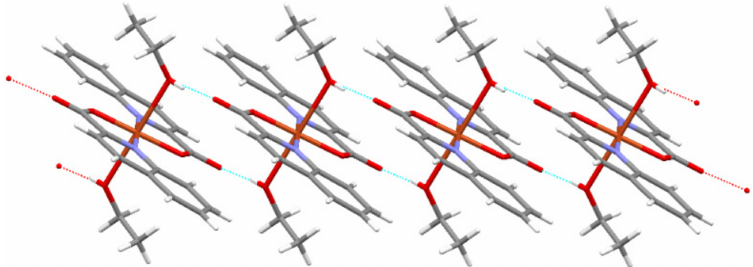
Figure 2. A short section of a chain in the structure of trans -[Cu(quin) 2 (EtOH) 2 ].